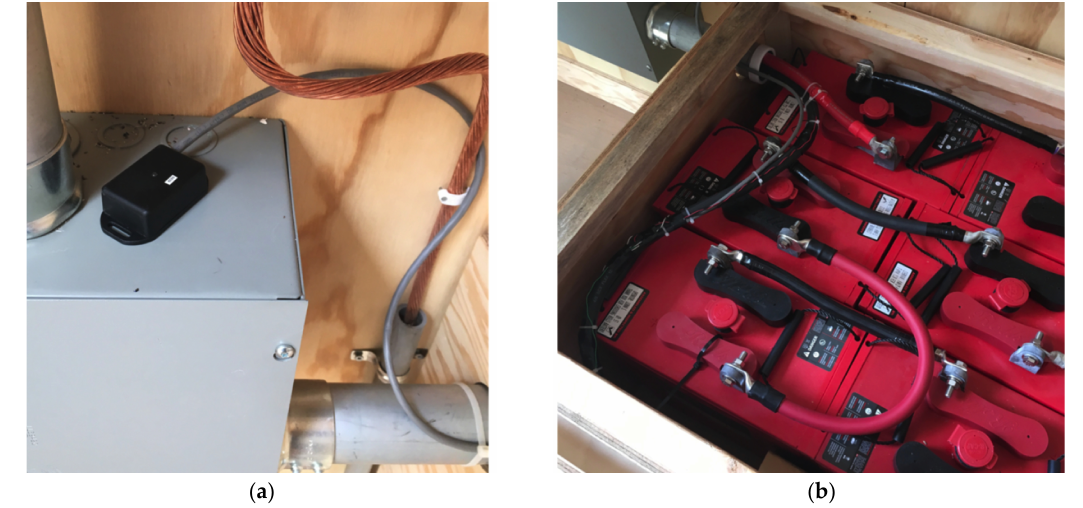
Figure 2. ( a ) Battery data logger device with integrated memory card shown resting on an electrical box; ( b ) Battery bank with main positive and negative cables to which the logger device is attached.